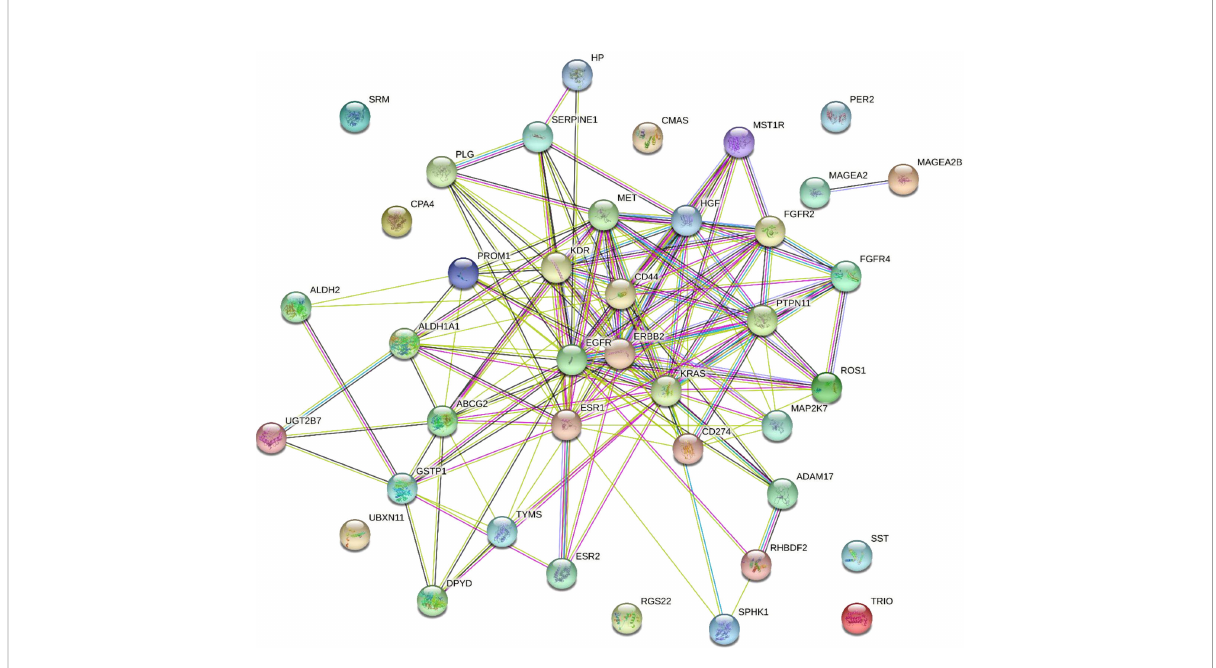
FIGURE 1 Gene interaction network of 41 esophageal cancer-related